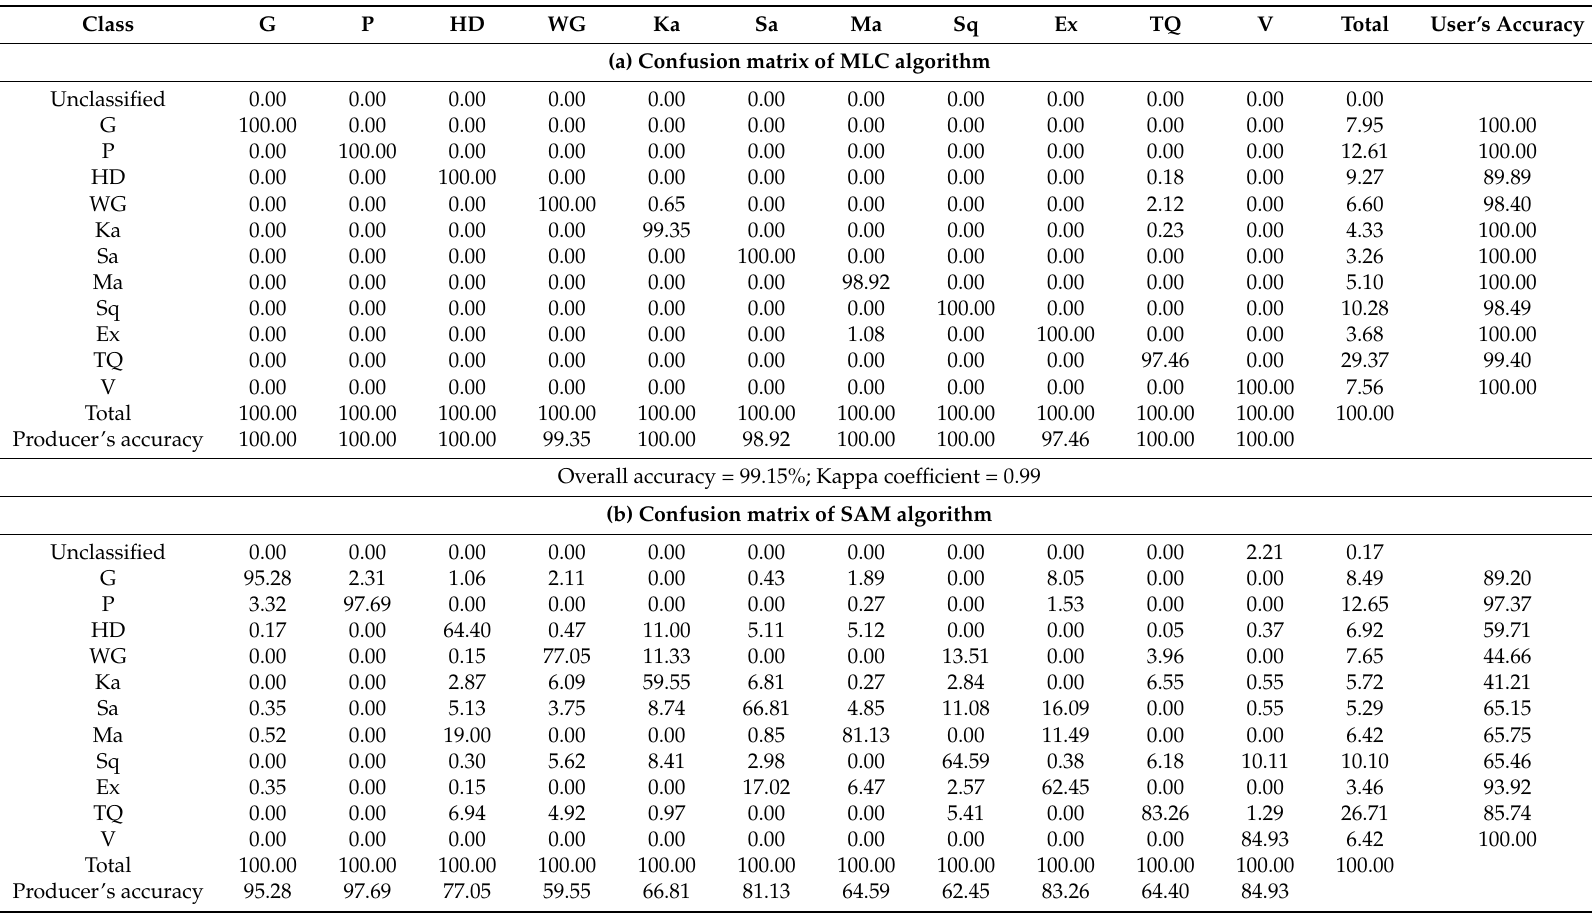
Table 3. Confusion matrix of MLC, SAM and SID algorithms applied to the lithological classes of Nakhl